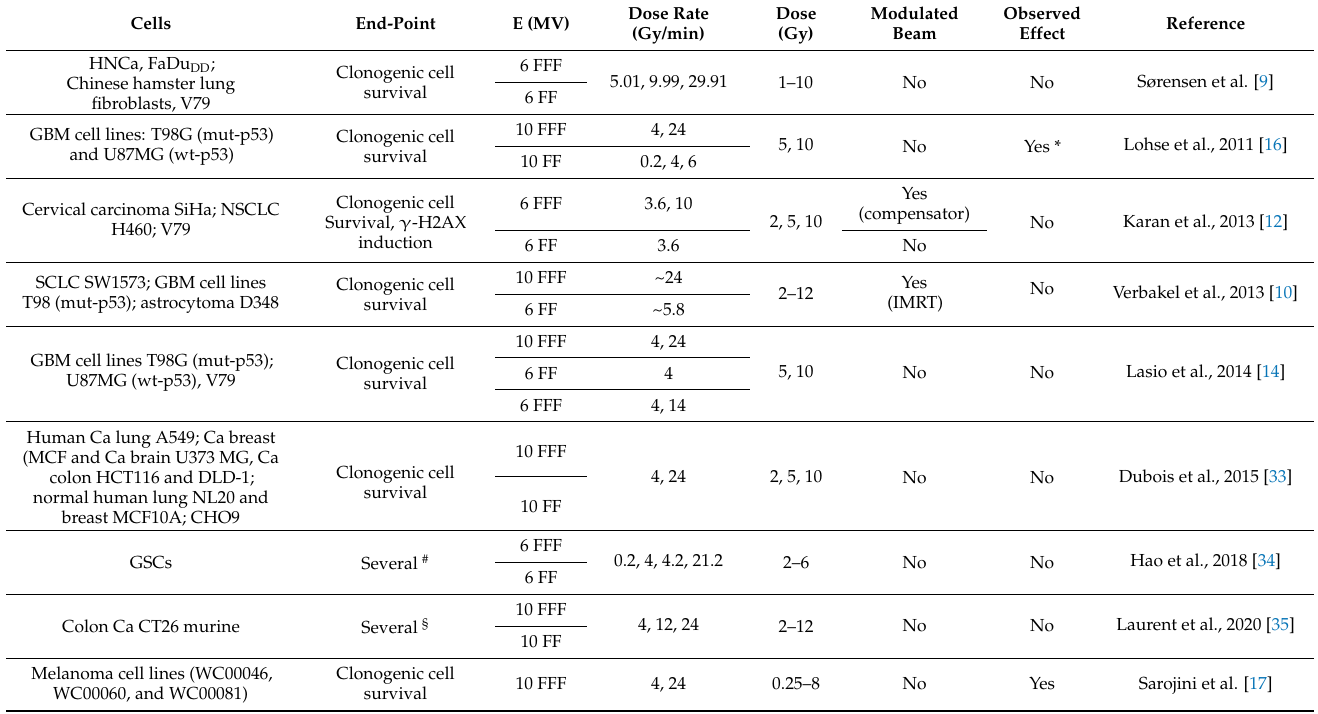
Table 4. List of relevant publications related to the different cell lines, end-points, irradiation setups, and effects discussed in the main